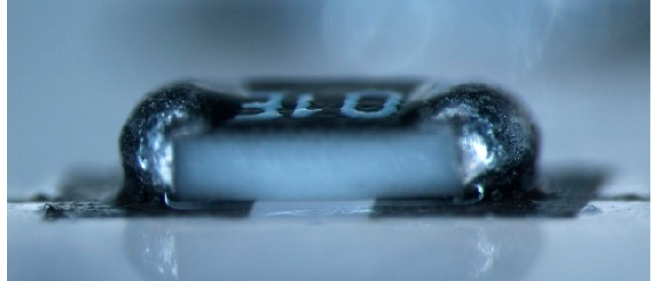
Figure 12. Aerosol jet printed Ag structures with LAB 2271 ink after soldering with SnBi solder at 180 °C.